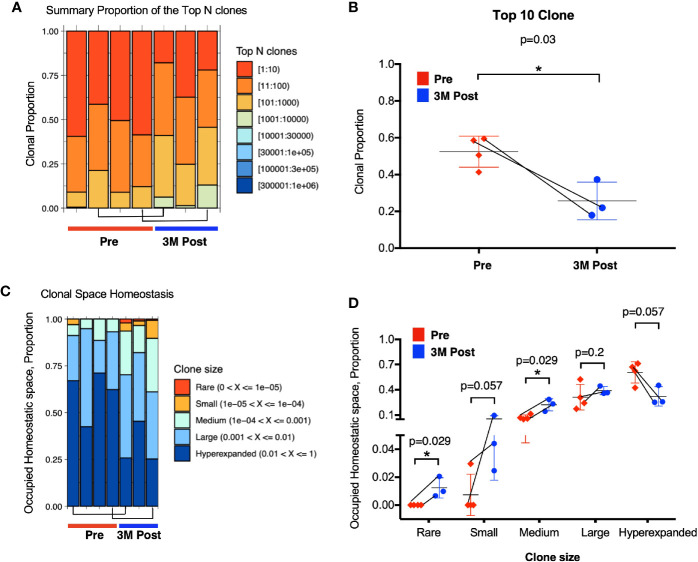
Enhanced TCR repertoire diversity after Bacillus Calmette-Guerin (BCG) treatment. (A) Clonal proportion of the top n clonotypes. Red bar represents the clonal proportion taken by the 10 most abundant clones. (B) Clonal proportion taken by top 10 most abundant clone at Pre (n=4, in red) and 3M post-BCG time point (n=3, in blue). 1 on Y-axis represents 100% of the total TCR repertoire. (C) Proportion of homeostasis space occupied by clonotypes classified as rare (0–0.00001), small (0.00001–0.0001), medium (0.0001–0.001), large (0.001–0.01), and hyperexpanded (0.01–1); 1 on Y-axis represents the 100% of the total TCR repertoire. (D) Proportion of occupied homeostatic space for pre (n=4, in red for each clone size) versus 3M post-BCG time points (n=3, in blue for each clone size) as classified by rare, small, medium, large, and hyperexpanded clone size, respectively. (B, D) Graphs show mean with standard deviation. *p<0.05 by Mann-Whitney U test. (A–D) Connecting lines showed two pairs of matched pre- and post-BCG samples.